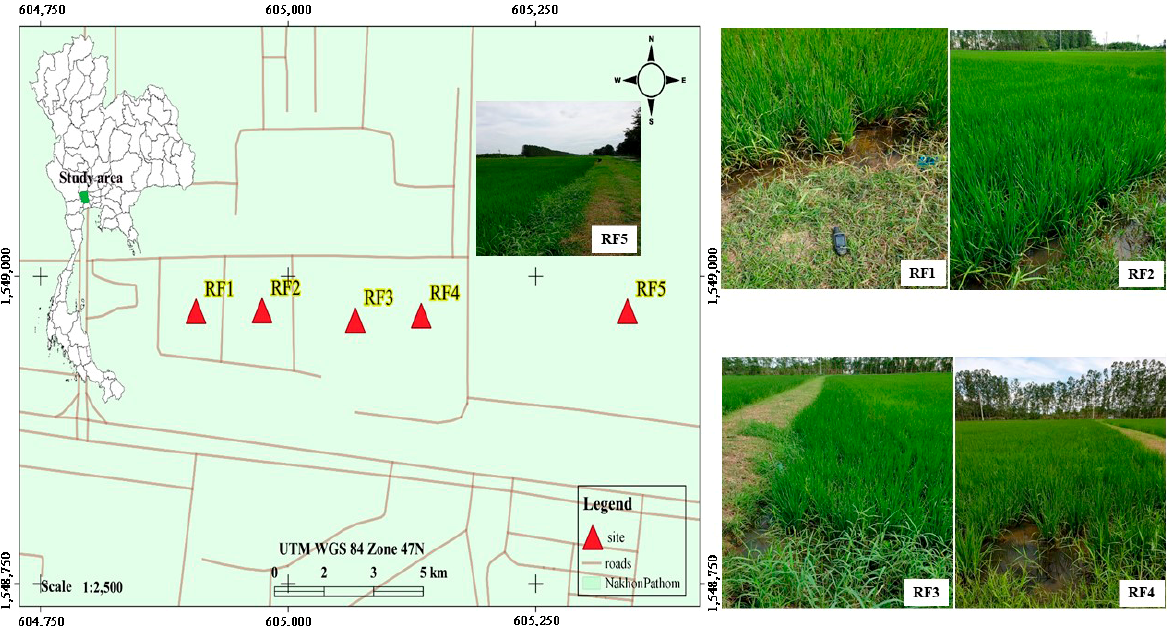
Figure 1. A map of five sampling sites was drawn using the QGis 3.14.1 program (https://www.qgis.org/en/site/, accessed on 9 August 2022).